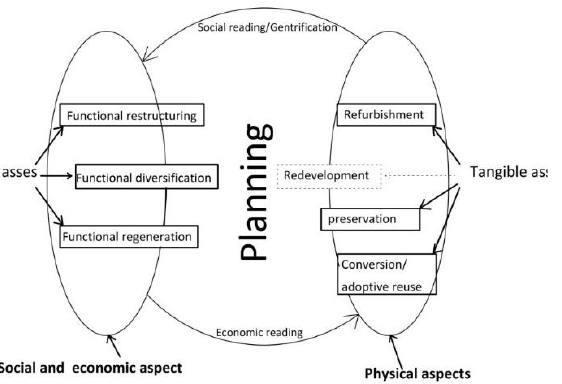
Figure 3. Classification of the different terms